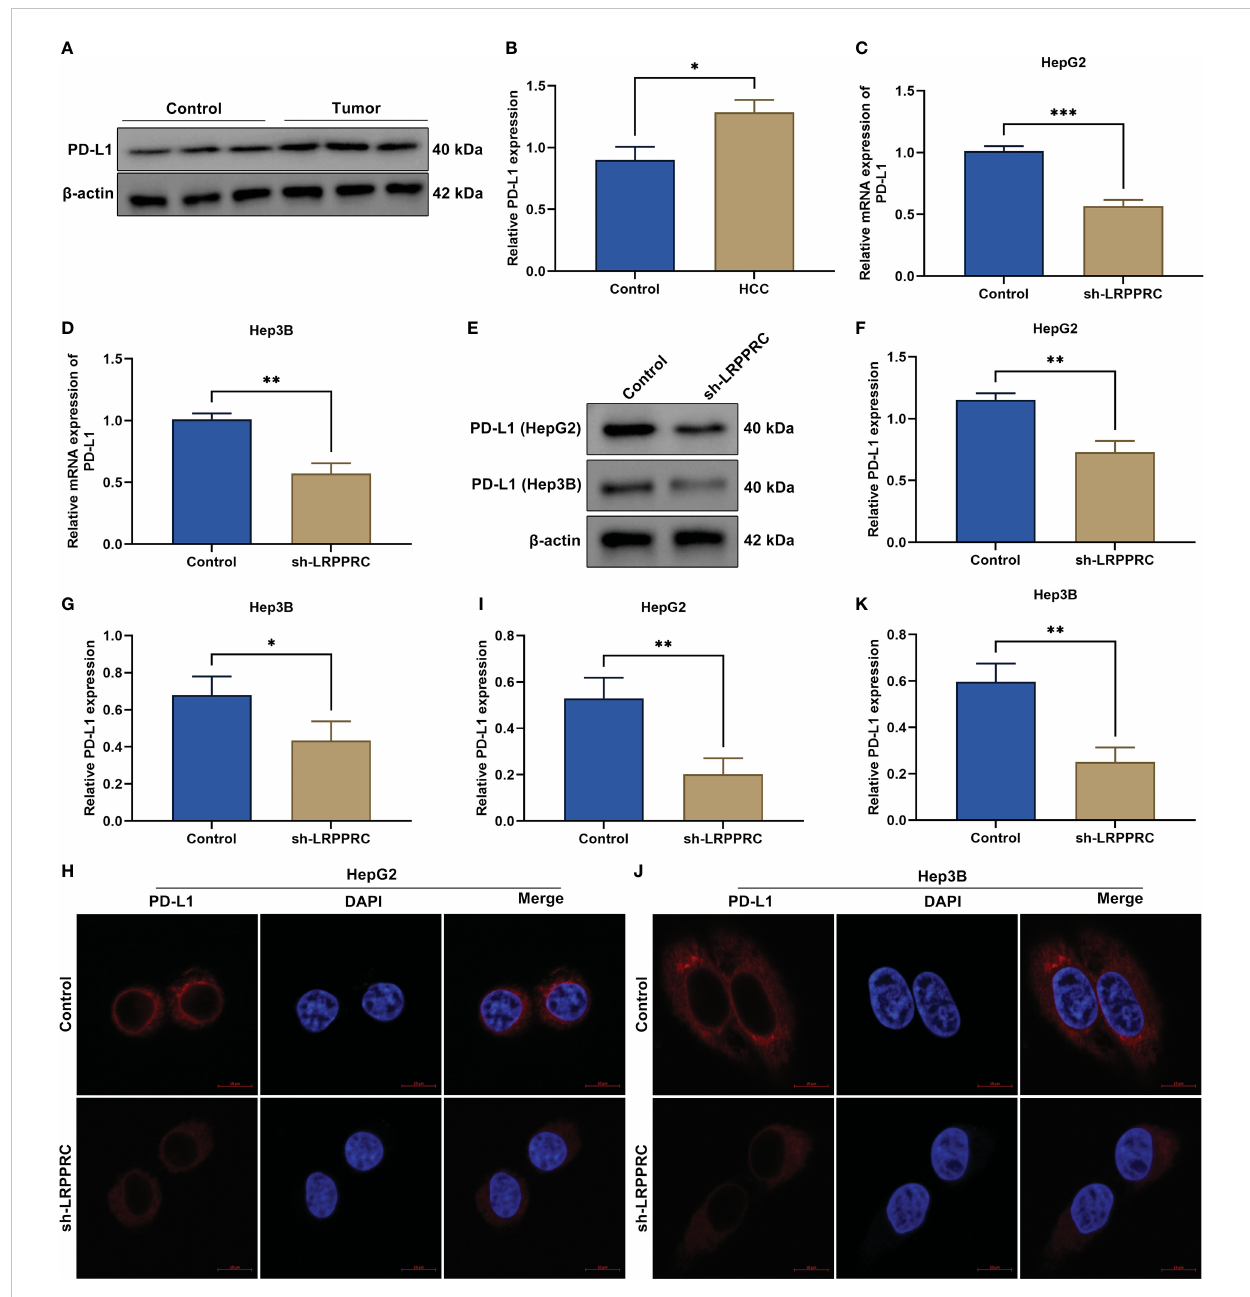
FIGURE 6 Leucine rich pentatricopeptide repeat containing (LRPPRC) upregulates PD-L1 expression in hepatocellular carcinoma (HCC) cells with an m 6 A- independent manner. (A , B) Immunoblotting of PD-L1 level in HCC tumors and control specimens. (C , D) Transcript level of PD-L1 in LRPPRC- knockout HepG2 and Hep3B cells. (E – G) PD-L1 protein level in HCC cells with LRPPRC loss. (H – K) Representative immuno fl uorescent staining photographs and quanti fi cation data of PD-L1 in LRPPRC-knockout HCC cell lines. Bar, 10 m m. * p < 0.05; ** p < 0.01; *** p <